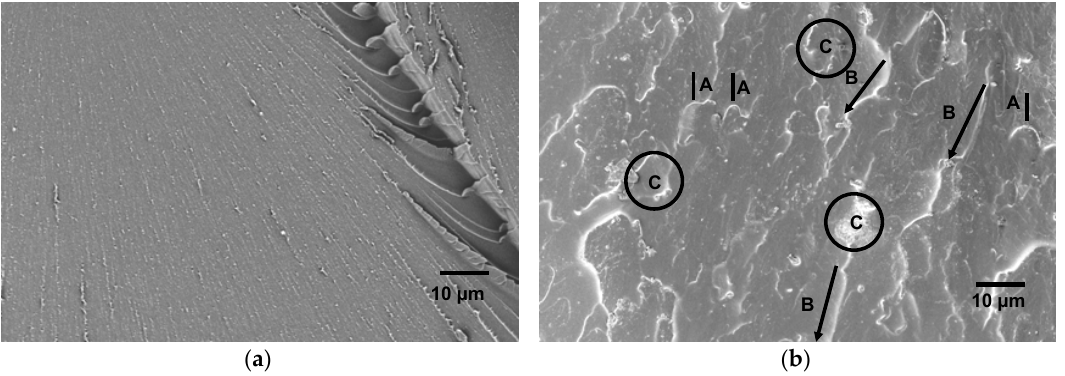
Figure 10. SEM images showing the fracture surface morphology of EP/eKraton-50 blend ( b ) compared with that of pure epoxy thermoset ( a ); crack pinning ( A ), crack bifurcation ( B ), and debonding ( C